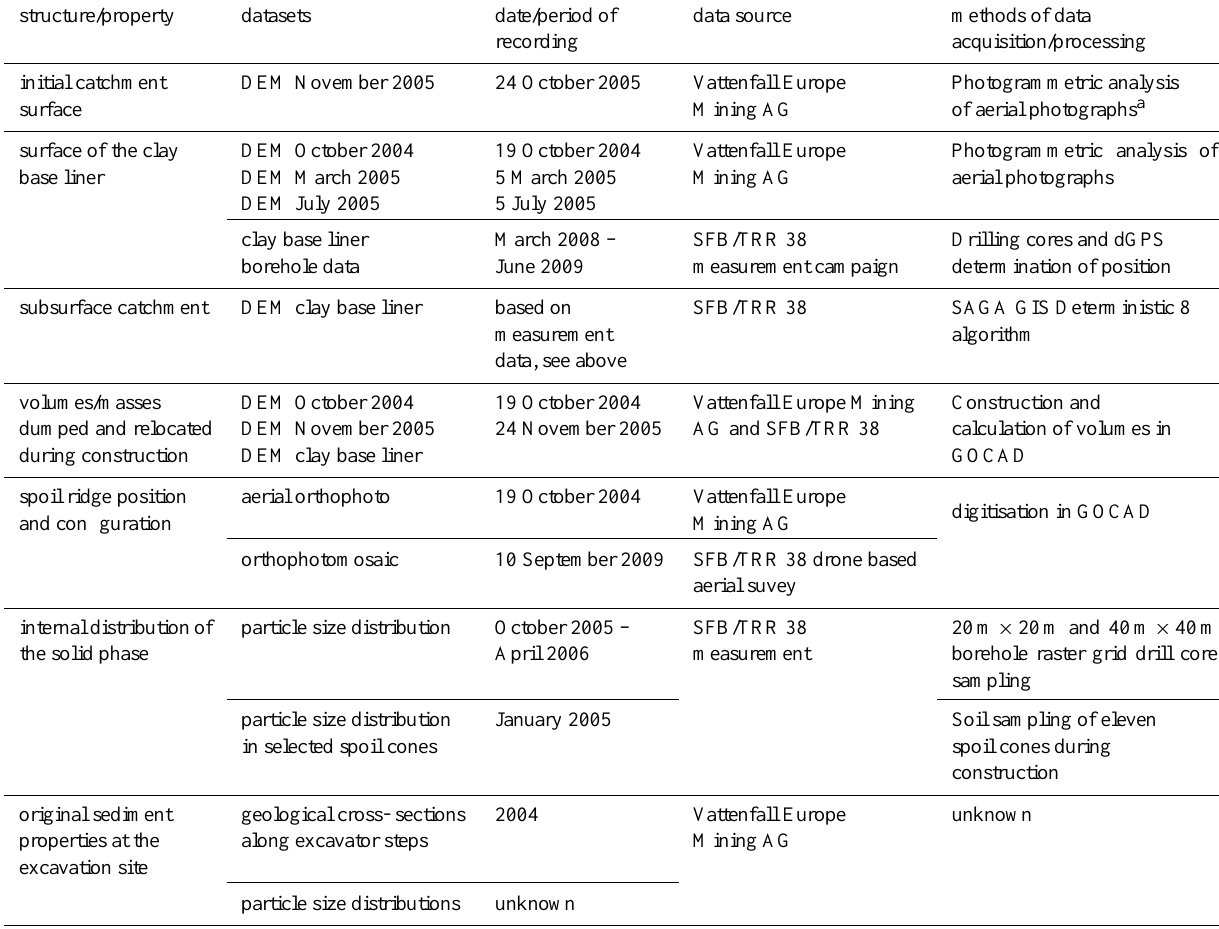
Table 1. Data used for deriving spatial boundaries and determining sediment properties in the structure generator model.